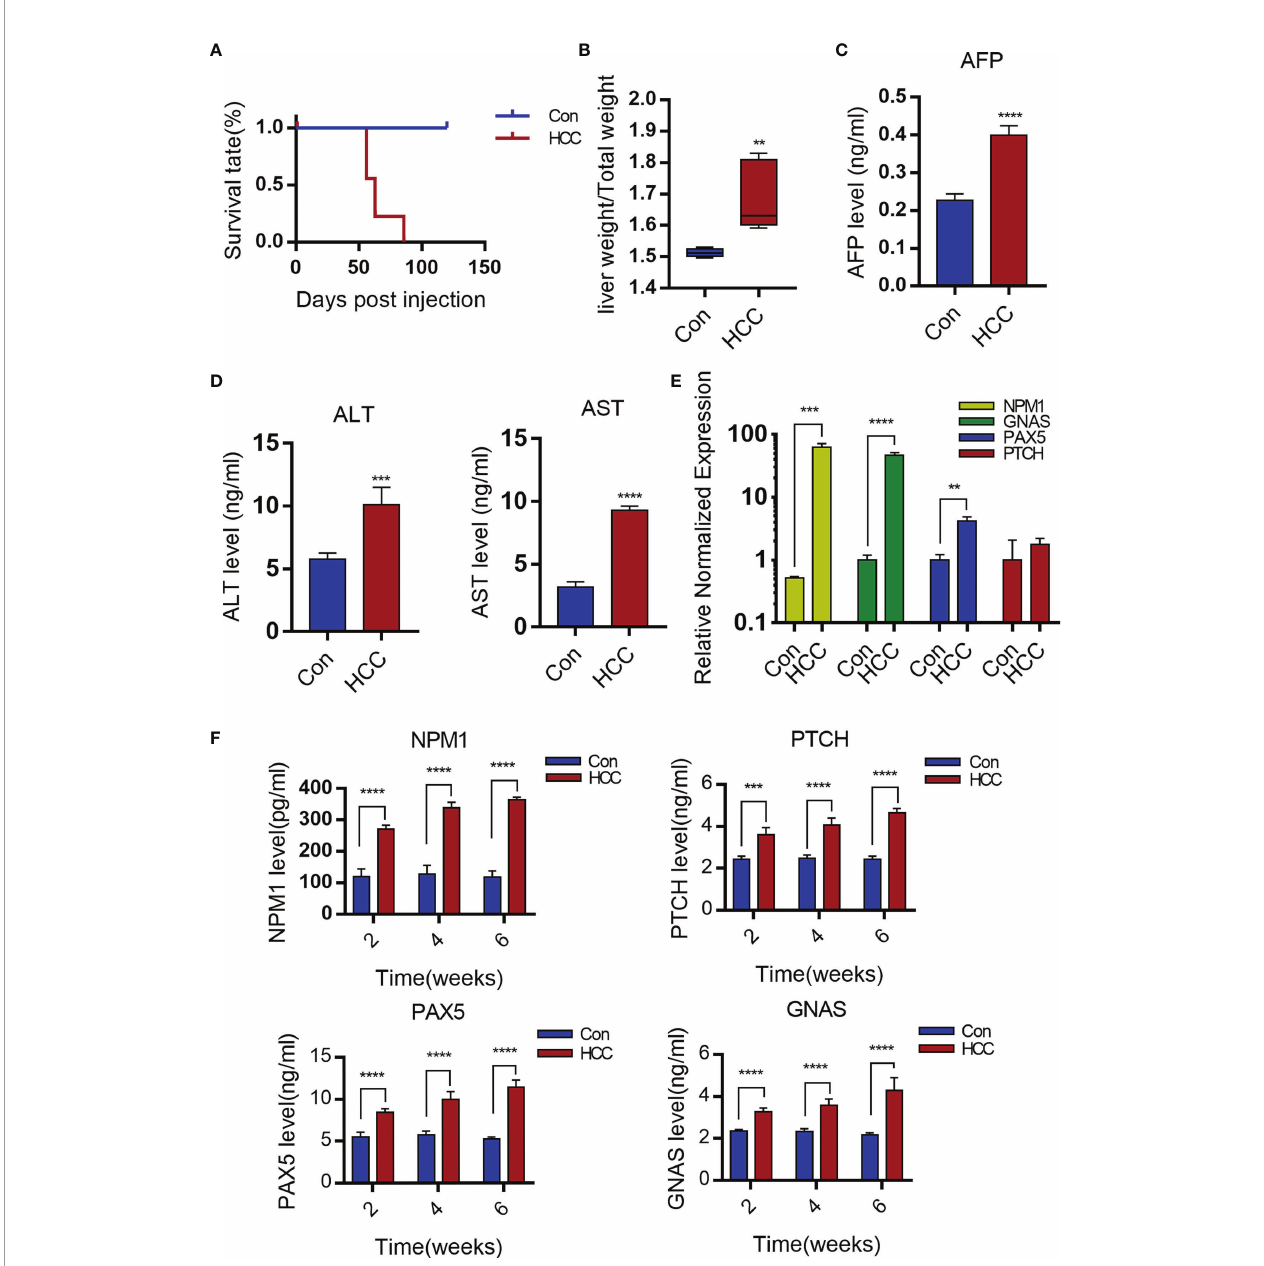
FIGURE 2 | Serological detection of primary mouse hepatocellular carcinoma. (A) The survival rate of mice after establishment of liver cancer model. (B) Liver weight relative to the whole-body weight of mice 6-week post injection. Data represent mean ± S.D. n=5. (C, D) AFP, ALT and AST levels of serum 6 weeks post- injection. Mean ± S.D; n=3, Statistical signi fi cance determined with t test; **P<0.05, ***P<0.001, ****P<0.0001; compared with the control. (E) Expression levels of GNAS, NPM1, PAX5 and PTCH genes in mouse liver tissue. Mean ± S.D; n=3, Statistical signi fi cance is determined with t test; ** P<0.01, ***P<0.001, ****P<0.0001; Compared with the control. (F) Serum levels of NPM1, GNAS, PAX5 and PTCH are time-dependence increases. Mean ± S.D; n=3, Statistical signi fi cance is determined with t test; ***P<0.001,